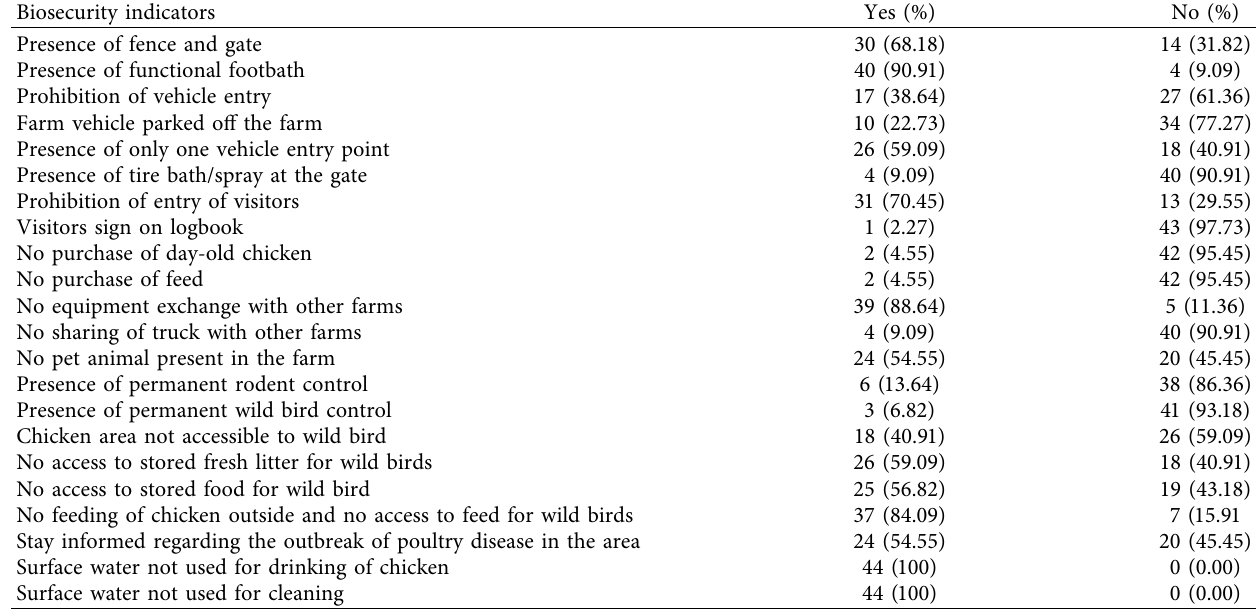
Table 4: The frequency and percentage of structural biosecurity indicators.